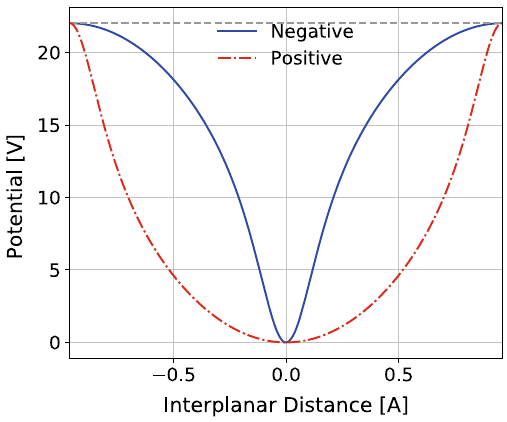
Fig. 4 Harmonic (red dash-dotted line) and non-harmonic (blue con- tinuous line) electric potential versus interplanar distance for positive and negative particles in a ( 110 ) Si crystal. The electric potential is extracted from Geant4 simulations. For the sake of comparison the electric potential for negative particles is shifted by half of the interpla- nar